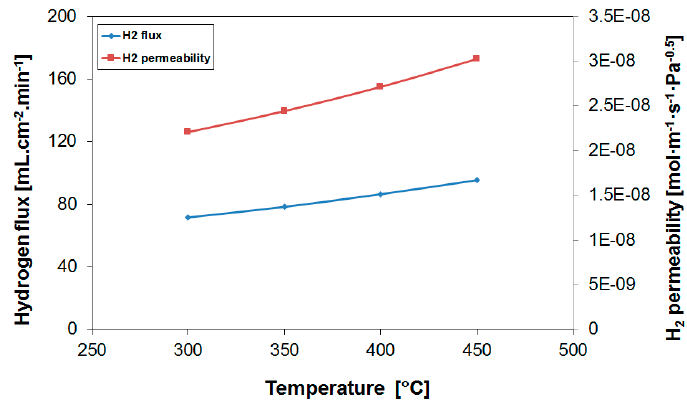
Figure 1. Hydrogen flux and permeability as a function of temperature for the Pd 77 Ag 23 alloy membrane. Feed: 80% H 2 in N 2 .